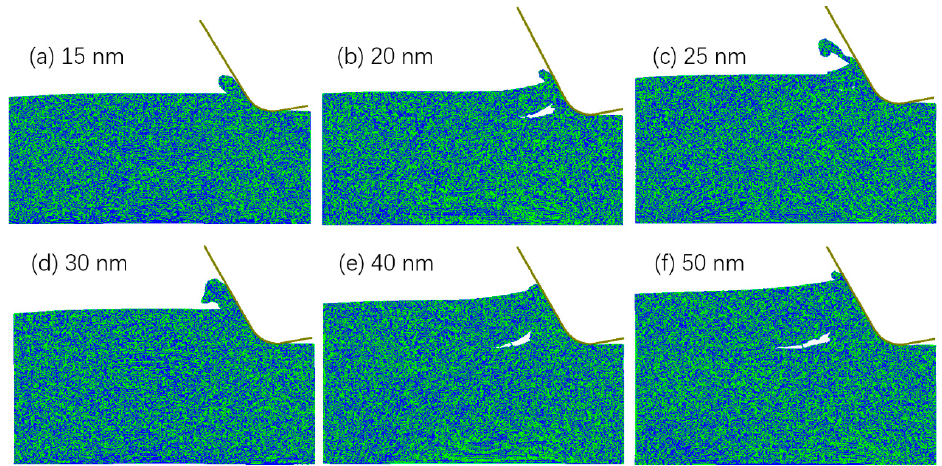
Figure 2. MD snapshots of the cutting mode under different t uc .